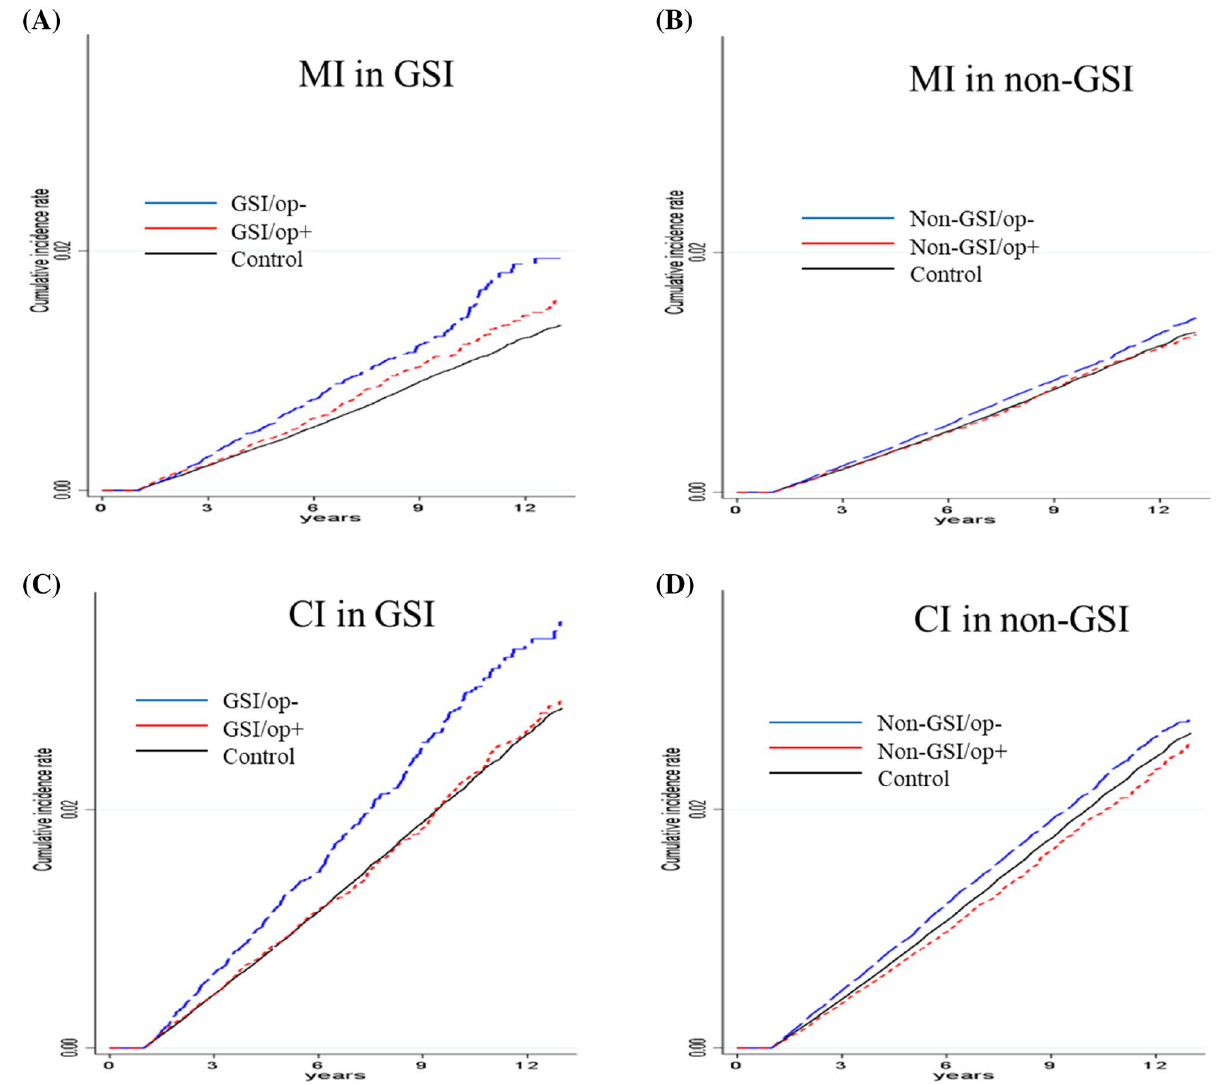
Figure 2. Cumulative incidences of myocardial infarction (MI) and cerebral infarction (CI) according to gallstone-related infection (GSI) and cholecystectomy. ( A , B ) myocardial infarction, ( A ) gallstone-related infection (GSI), ( B ) non-GSI. ( C , D ) cerebral infarction, ( C ) GSI, ( D ) non-GSI. op,